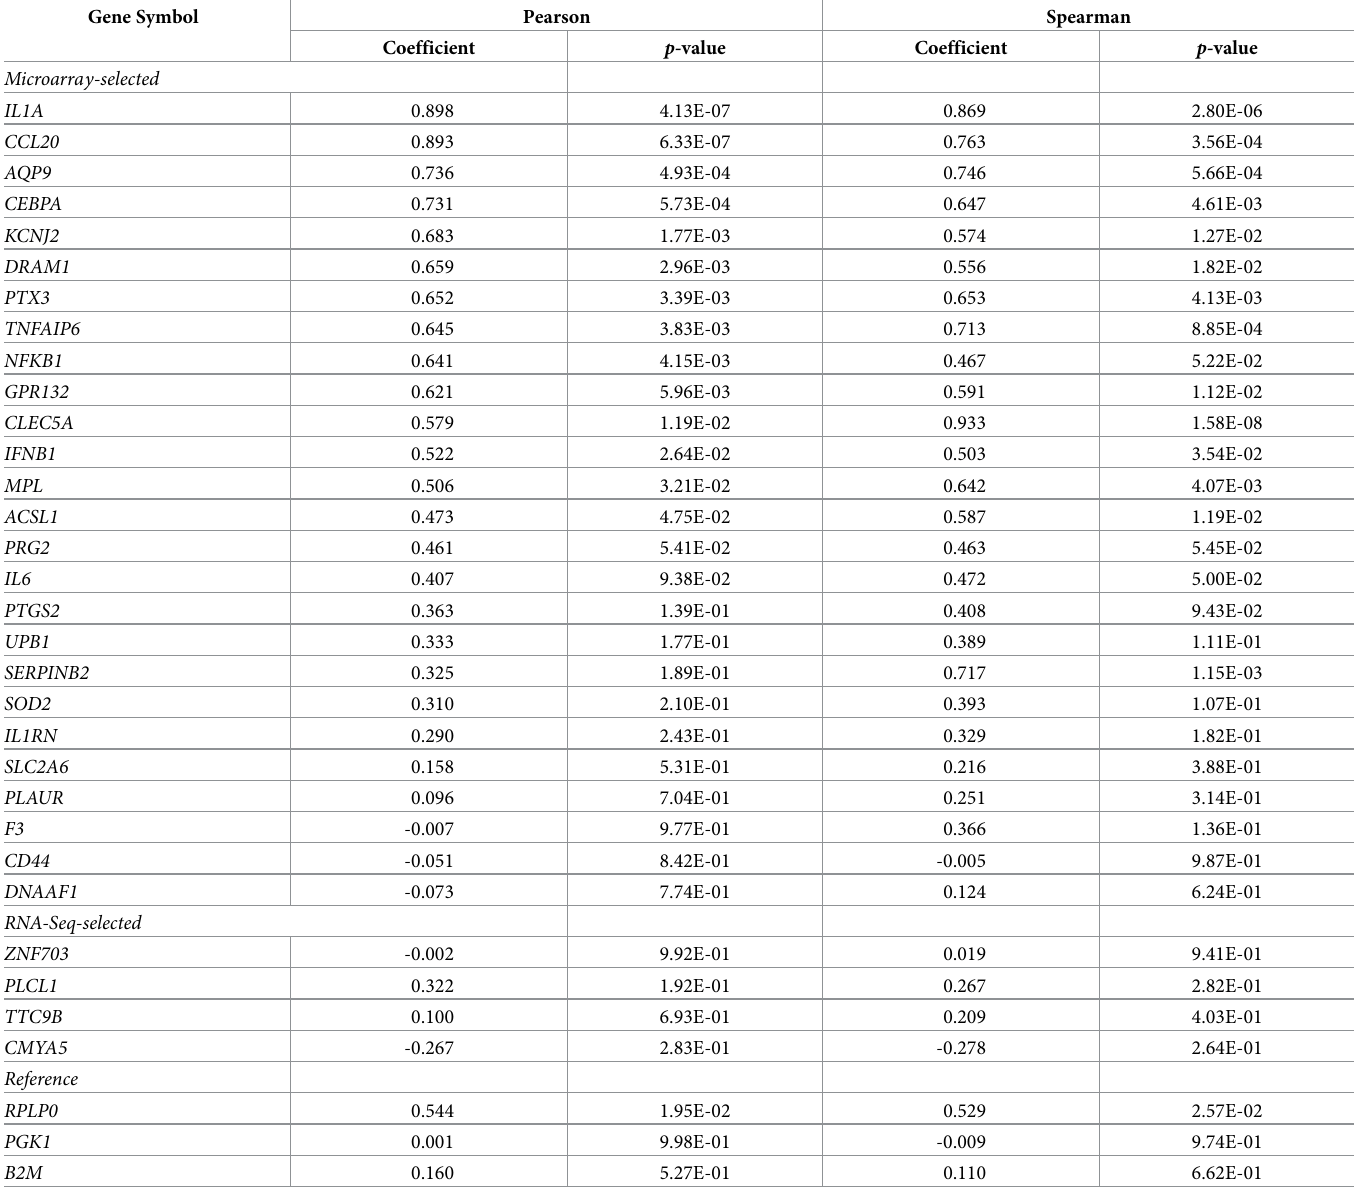
Table 3. Correlation of expression levels between mRNA-Seq and nCounter in 19